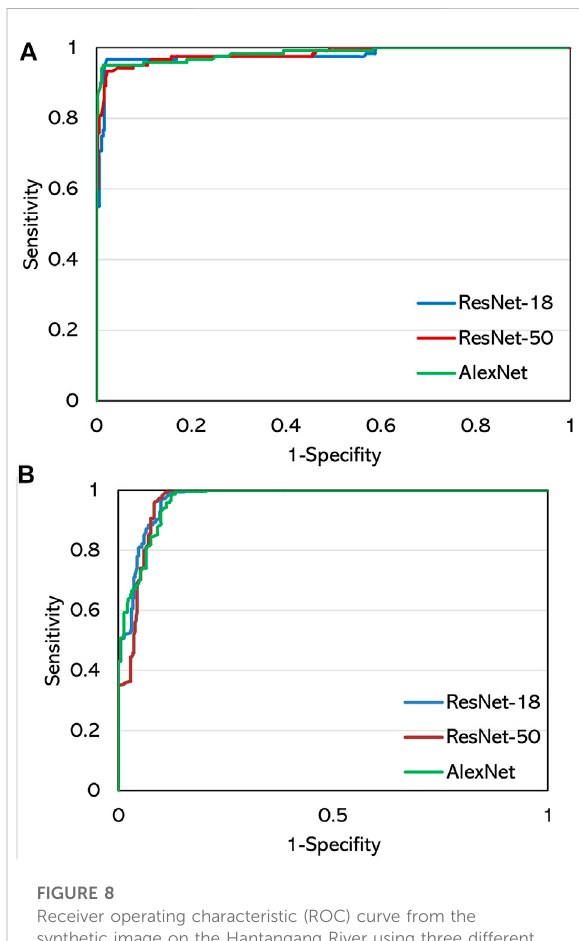
FIGURE 8 Receiver operating characteristic (ROC) curve from the synthetic image on the Hantangang River using three different pretrained networks: (A) 2-class classi fi cation and (B) 4-class classi fi cation.